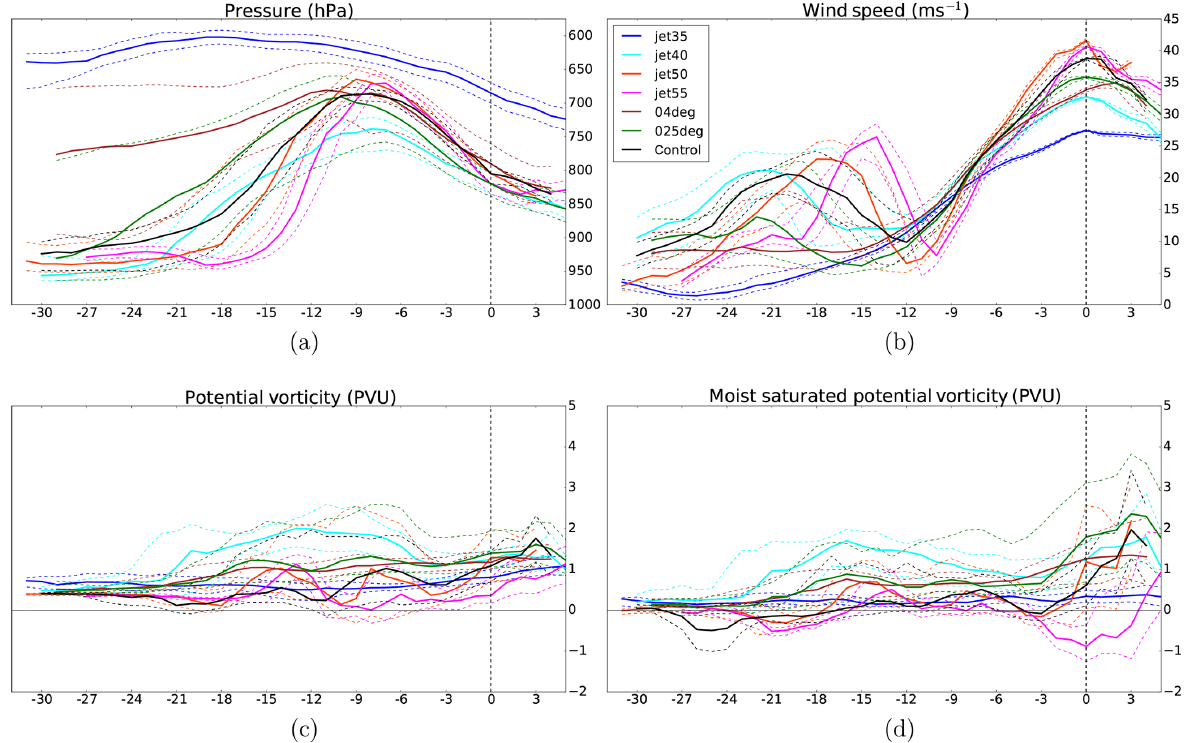
Figure 10. Time series (hours relative to the time of identification of each airstream) of (a) pressure, (b) wind speed, (c) PV and (d) MPV ∗ along SJ trajectories for the control simulation and for the runs with modified jet stream (jet35, jet40, jet50, jet55) and model resolution (025deg, 04deg). Solid lines indicate the median values of each set of trajectories, and dashed lines indicate 25th- and 75th-percentile